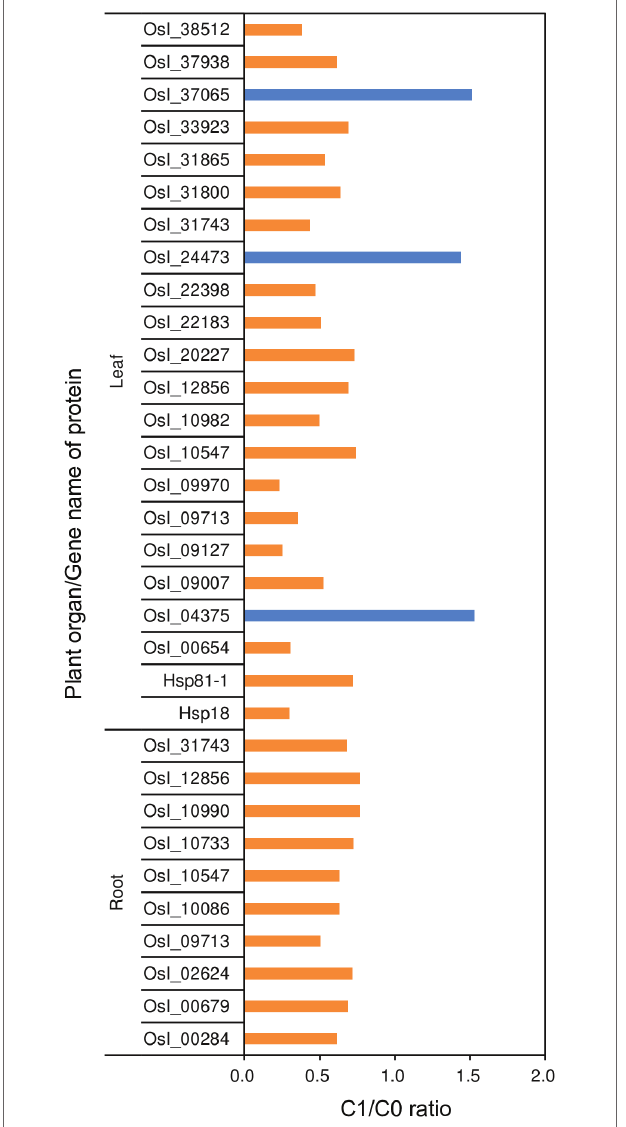
FIGURE 5 | Fold changes of differentially modulated heat-shock and related proteins in roots and leaves of the rice plants grown with biochar application (C1) compared to plants grown without biochar application (C0). Orange and blue bars represent the down- and up-modulated proteins in the C1 treatment compared to the C0 treatment, respectively, respectively.